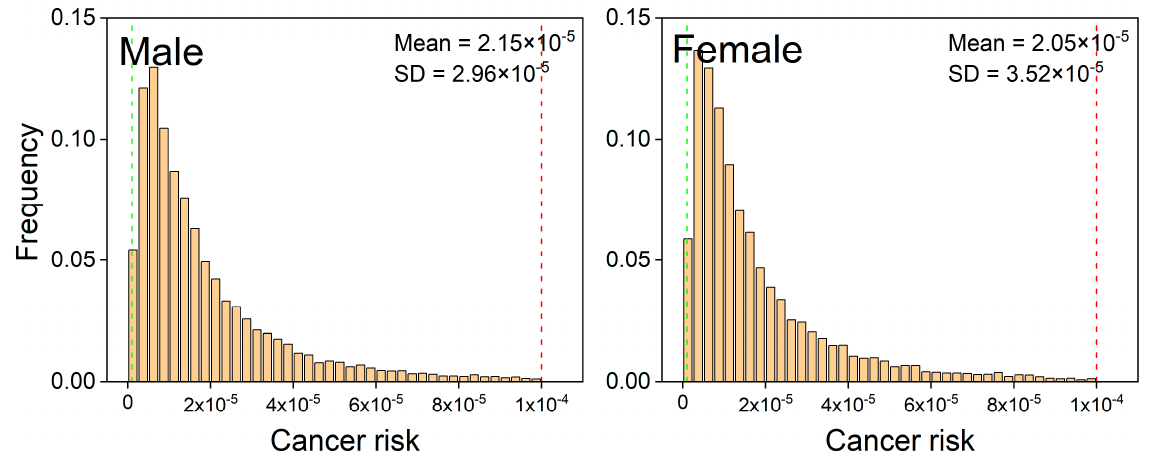
Figure 6. Distributions of lifetime cancer risk for male and female population groups derived using Monte Carlo simulations. Green and red vertical lines represent the US EPA acceptable risk level and serious risk level, respectively.